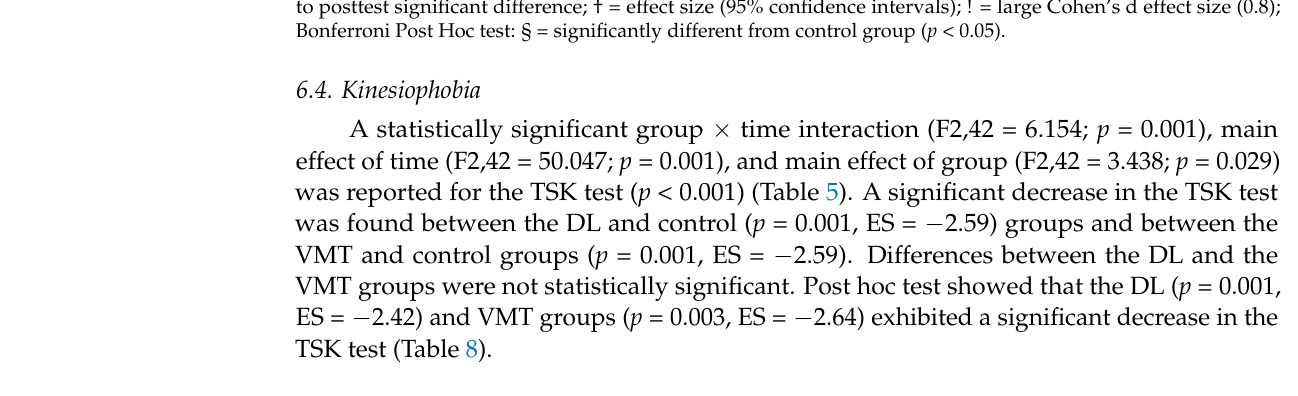
Table 8. Between and within-group changes in TSK